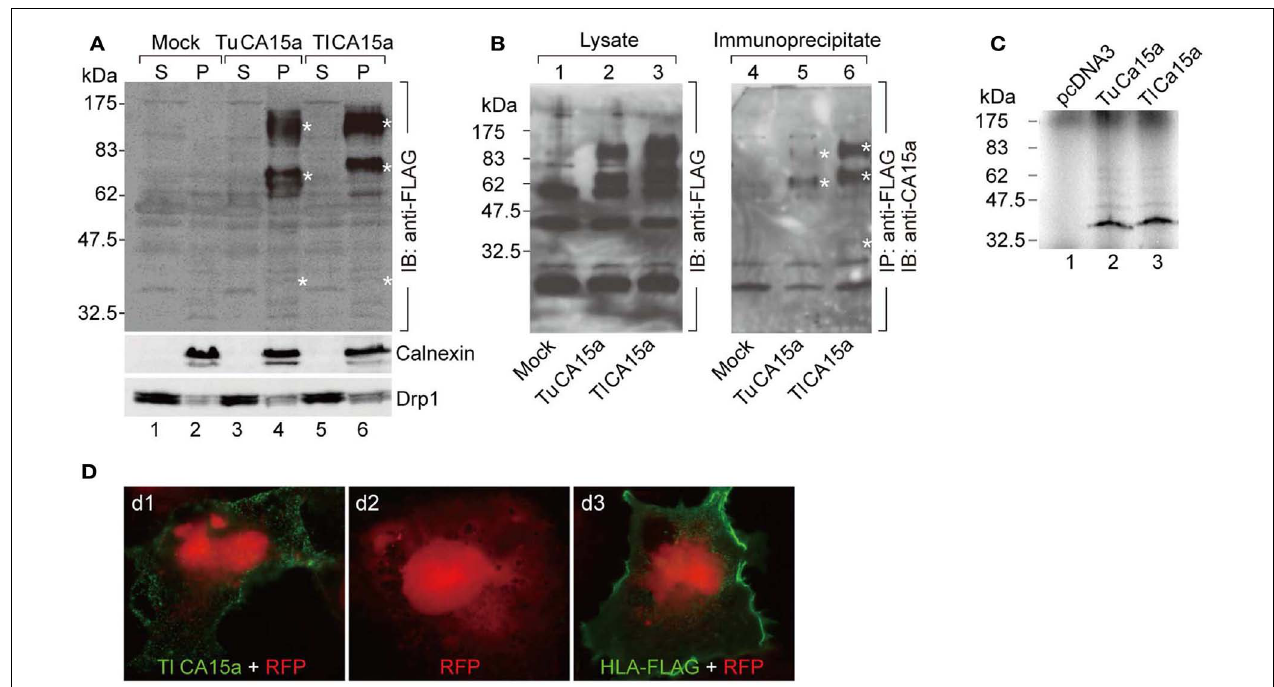
lysates were subjected to immunoprecipitation with anti-FLAG antibody beads followed byWestern blotting with anti-CA15a antibody (lanes 4–6).The lysates (40 µ g of proteins) were also analyzed byWestern blotting with anti-FLAG antibody (lanes 1–3). Asterisks indicate the bands corresponding to monomer, dimer, and tetramer of CA15-FLAG. (C) TuCA15-FLAG (lane 2) and TlCA15-FLAG (lane 3) were translated in vitro in the presence of [ 35 S]methionine and [ 35 S]cysteine, and were then analyzed by SDS–PAGE followed by autoradiography. (D) Cell surface expression of CA15a demonstrated by immunofluorescence. COS7 cells were transfected with red fluorescent protein (RFP, red) alone (d2) or along with eitherTlCA15-FLAG (d1) or HLA-FLAG (d3). Non-permeabilized cells were analyzed by immunofluorescence microscopy with anti-FLAG antibody (green). HLA (human leukocyte antigen) or MHC (major histocompatibility complex) is a cell surface